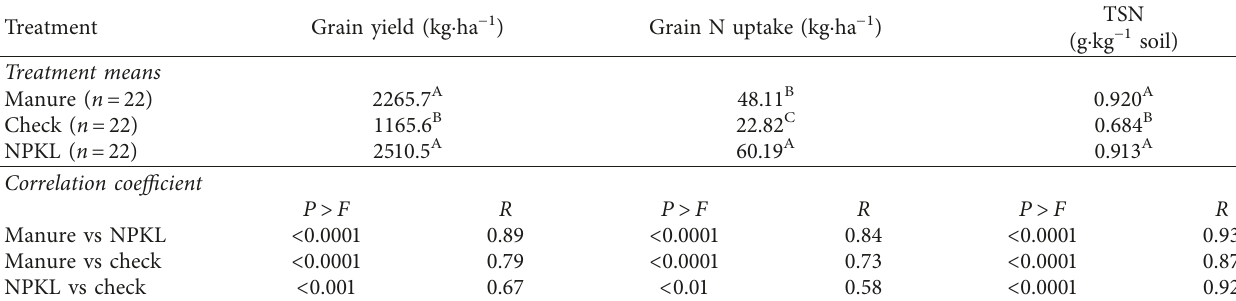
Table 3: Analysis of variance for wheat grain yield, grain N uptake, and TSN including summary of relationships between these variables in manure, check, and NPKL treatments (1990–2015) of Magruder Plots located at Stillwater in Oklahoma, USA.